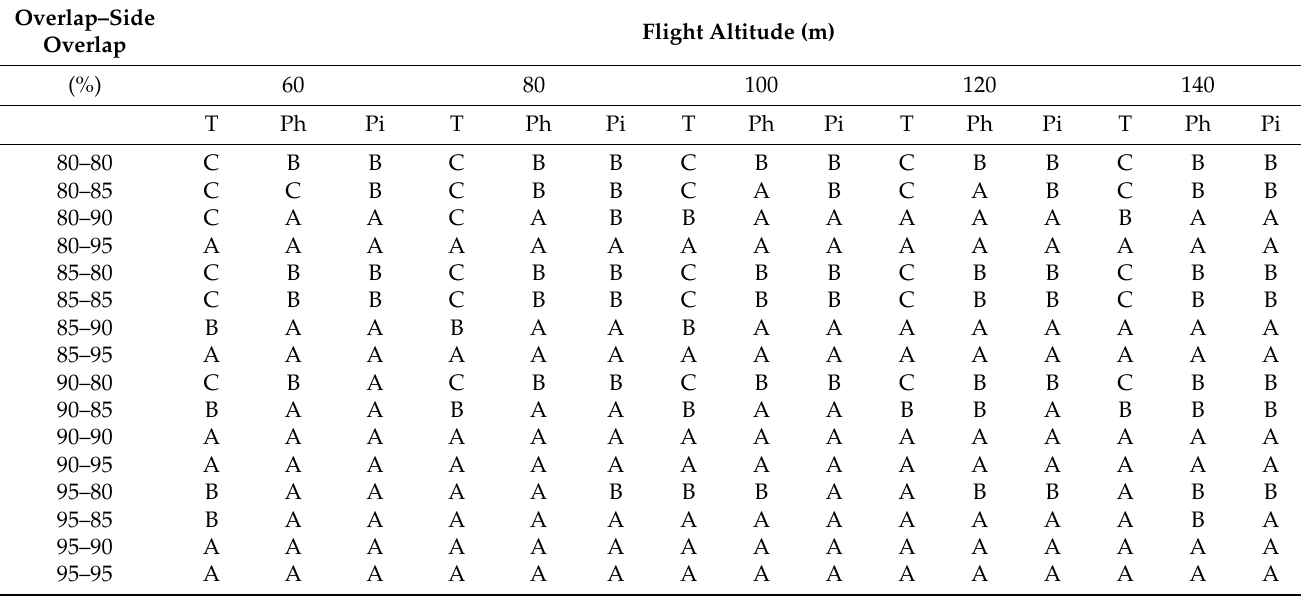
Table 2. Results of image processing by each SfM